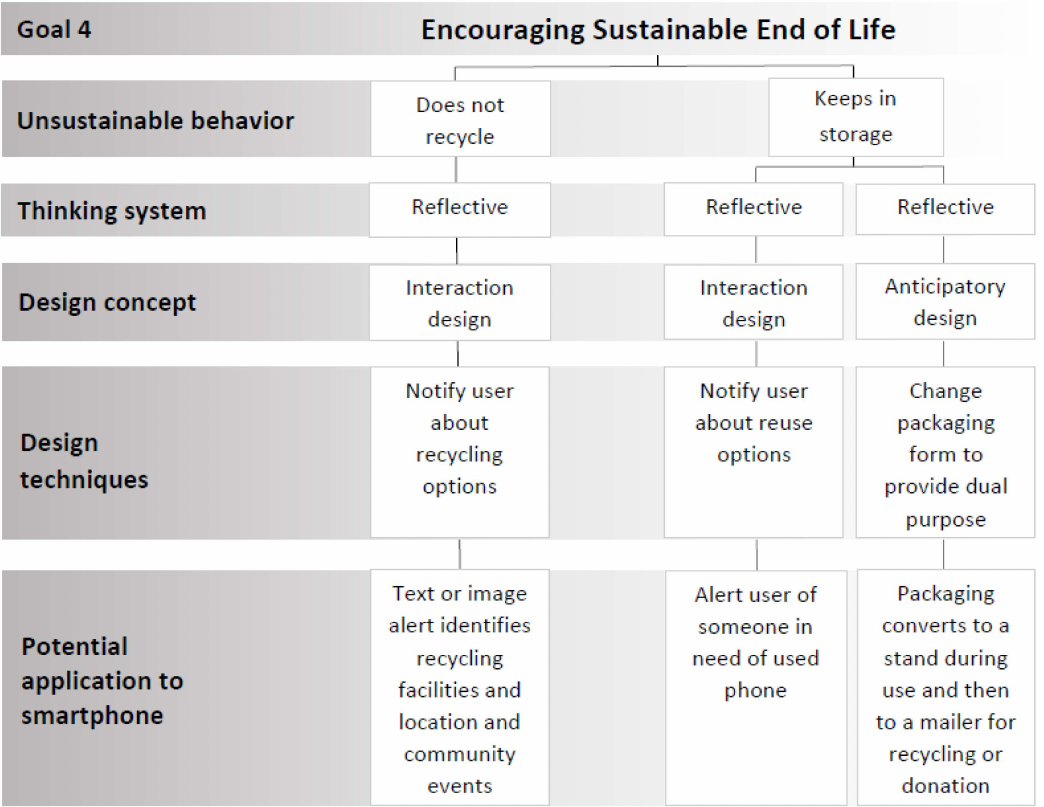
Figure 6. SBD framework applied to meet Goal 4, “Encouraging Sustainable End of Life Management”: examples of how to educate or inform users of or encourage participation in recycling or reuse